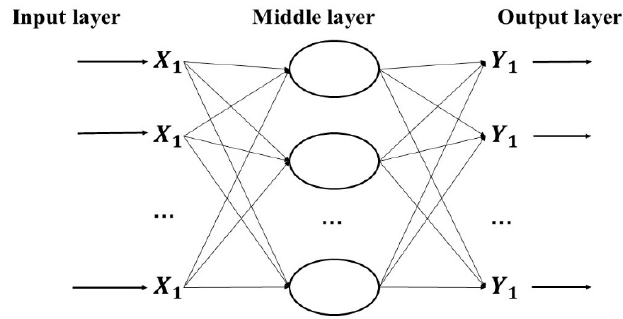
Figure 3. Structure of the RBF neural network.